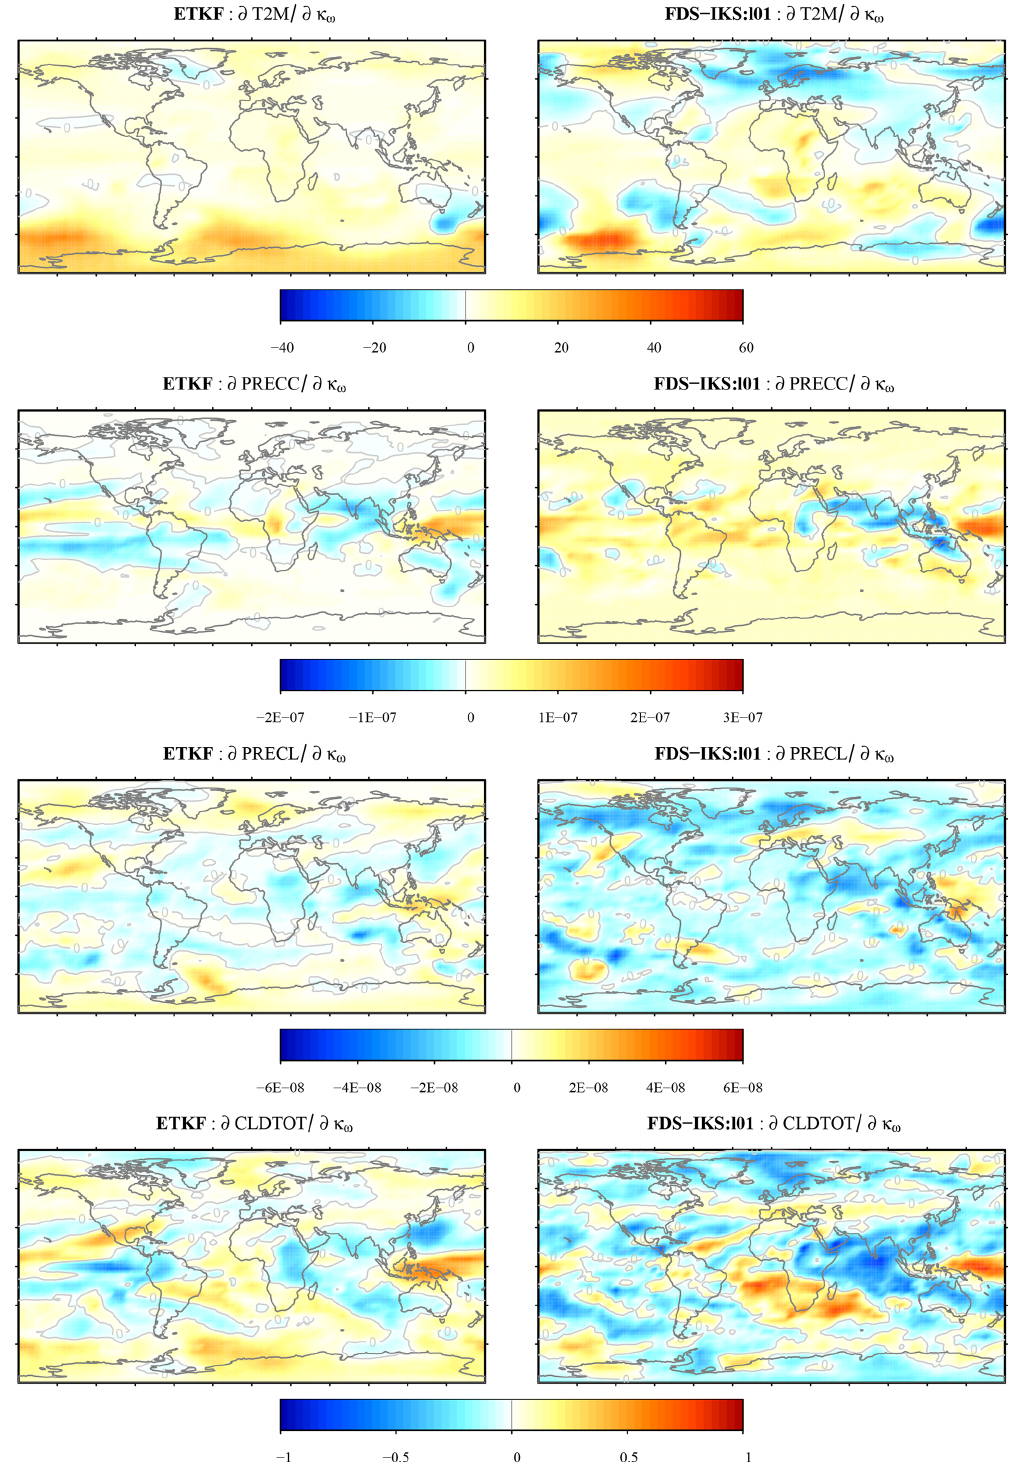
Figure 8. CESM experiment. Sensitivity of several atmospheric variables to the ocean background vertical diffusion parameter ( κ ω ; POP2.bckgrnd_vdc1) in the ocean model estimated as ensemble sensitivity (from the ETKF background ensemble) and the local FDS for the first iteration of both the FDS-MKS and the FDS-IKS. The atmospheric variables are 2m air temperature (T2M), total convective precipitation rate (PRECC), large-scale (stable) precipitation rate (PRECL), and vertically integrated total cloud cover (CLDTOT). Isolines at value 0 shown in